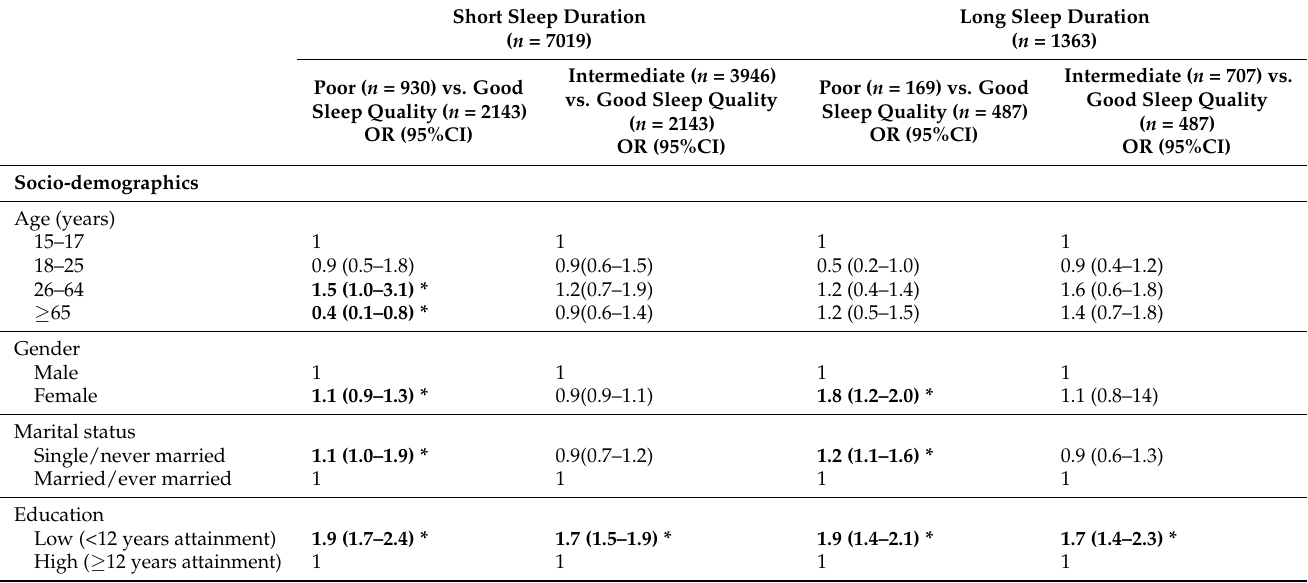
Figure 1. Percentage of depression prevalence associated with sleep duration and quality. The risk factors for poor and intermediate sleep quality in the short- and long-sleep duration groups are presented in Table 3. The variable that significantly increased the risk of poor sleep quality in the short sleep duration group was the age variable. Education, season factors, and living in an urban area significantly increased the risk of poor and intermediate sleep quality in all groups of all sleep durations. The variables that significantly increased the risk of poor sleep quality in all of the groups of sleep duration were gender, marital status, wealth index, physical activity, and chronic illness. Table 3. Results of the multinomial logistic regression analysis of variables predicting sleep